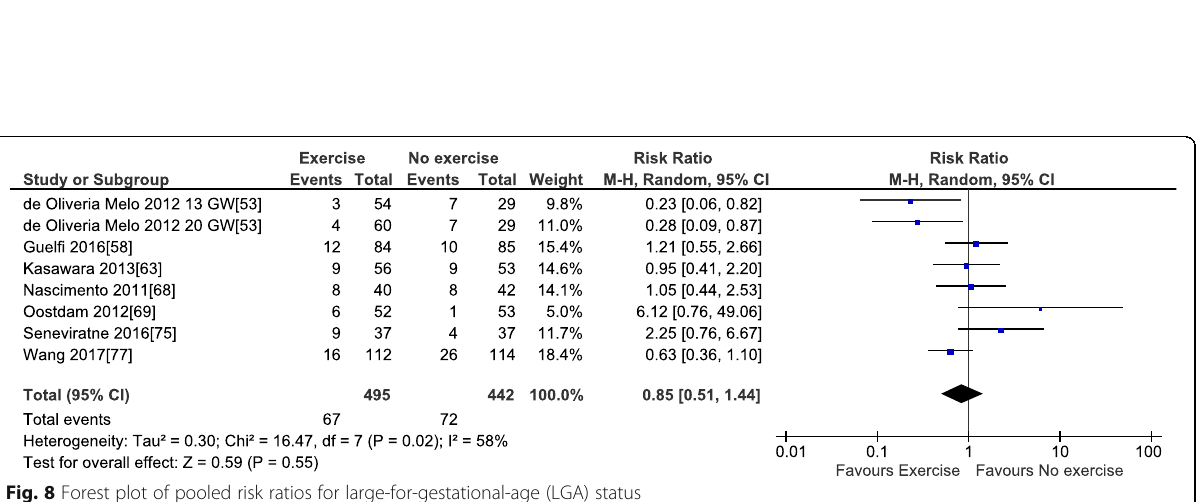
Fig. 8 Forest plot of pooled risk ratios for large-for-gestational-age (LGA)